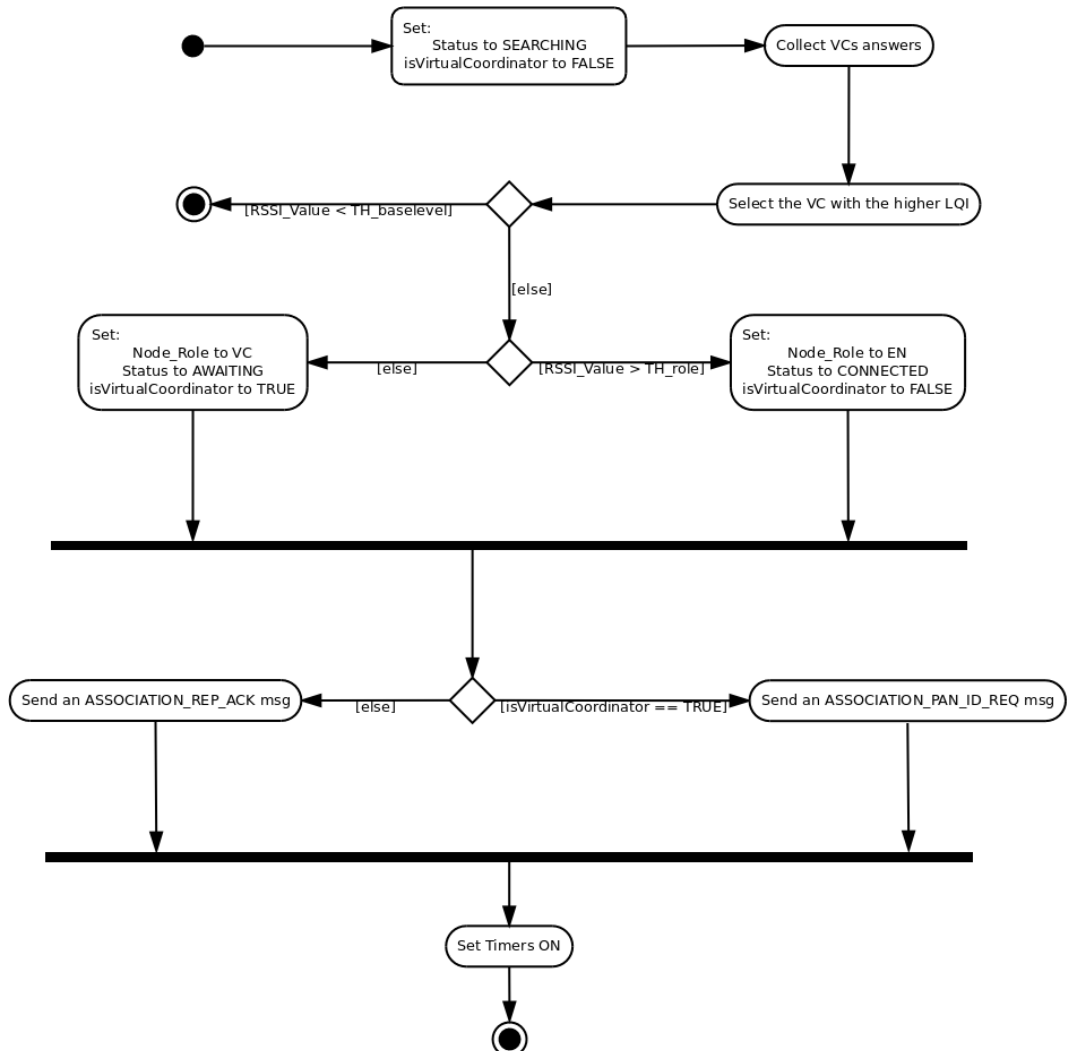
Figure 7. Dynamical role selection process